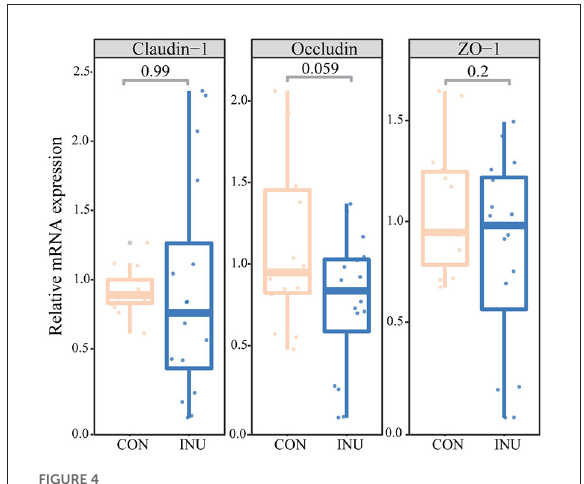
FIGURE4 The gene expression of tight junction proteins in weaned goats fed maize-grain based diet (CON) or low-carbon high inulin diet